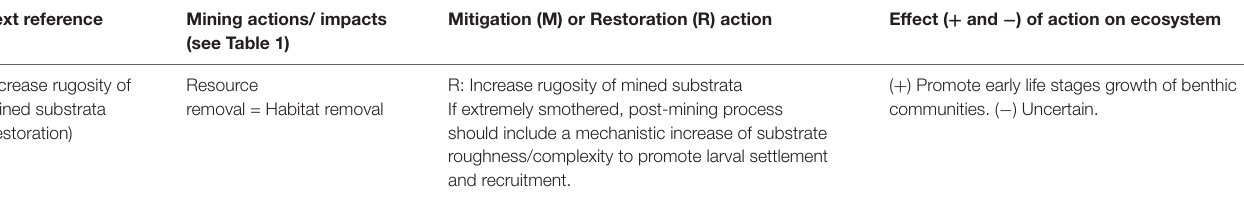
TABLE 4 | Proposed mitigation and restoration actions specifically for Fe-Mg crust mining at